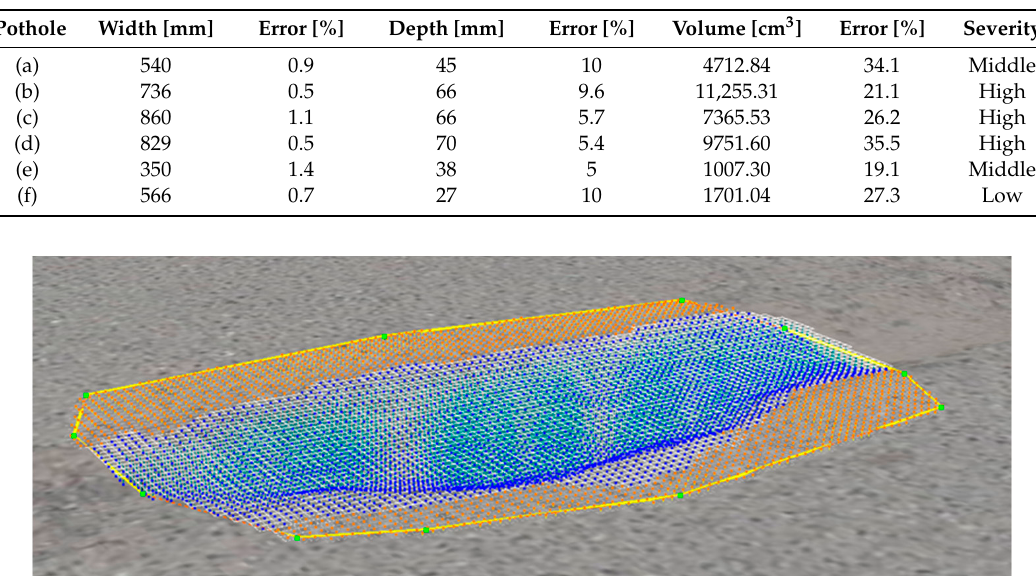
Figure 12. Flexible pavement pothole for recommendation validation. ( a ) Pathole 1; ( b ) Pathole 2; ( c ) Pathole 3; ( d ) Pathole 4; ( e ) Pathole 5; and ( f ) Pathole 6. Table 6. Dimensions of potholes measured in terrain (real). Table 7. Dimensions of potholes measured in model at 10 m and error.